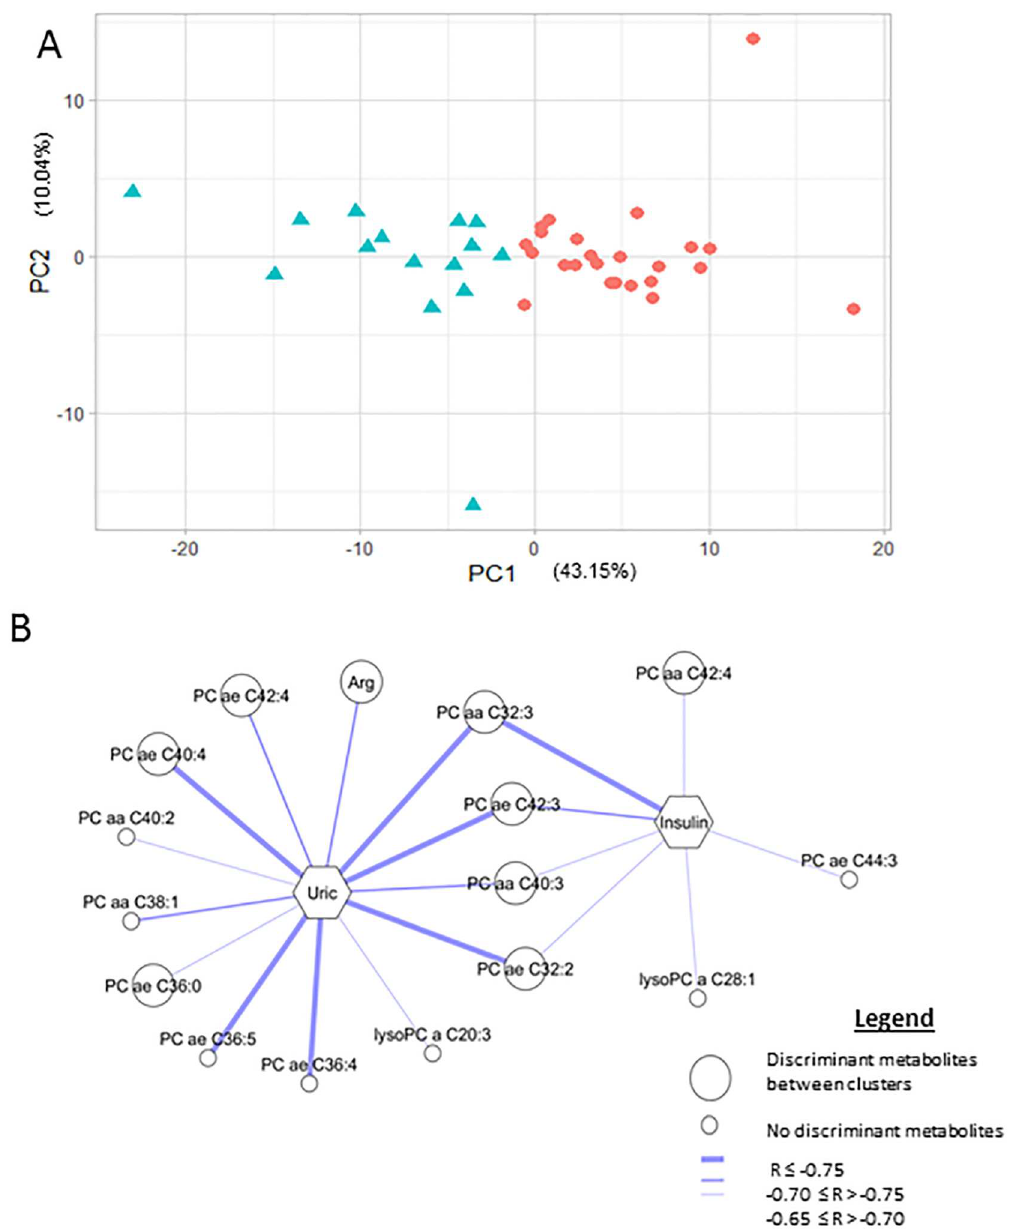
Fig 2. A. Scatter plot of cluster 1 (red dots) and cluster 2 (blue triangles) derived from K-means cluster analysis in the first (PC1) and second (PC2) principal components. B. Network of the correlations at T6–T0 of phenotype 1 between changes in uric acid (Uric) and fasting insulin (Insulin) and metabolites is represented. Only correlations with statistical significance and corrected by false-discovery rate are drawn. The most discriminant metabolites between clusters (correlation with PCA r > 0.75 or r < -0.75) are represented by a big circle, and other metabolites by a small circle. Correlations r (cid:20) -0.75 are represented by a thick line, correlations -0.70 (cid:20) r > -0.75 are represented by a medium line and -0.65 (cid:20) r > -0.70 by a thin line. Arg: arginine, PC aa: diacyl phosphatidylcholines, PC ae: acyl-alkyl phosphatidylcholines, and lysoPC: lysophosphatidylcholines.